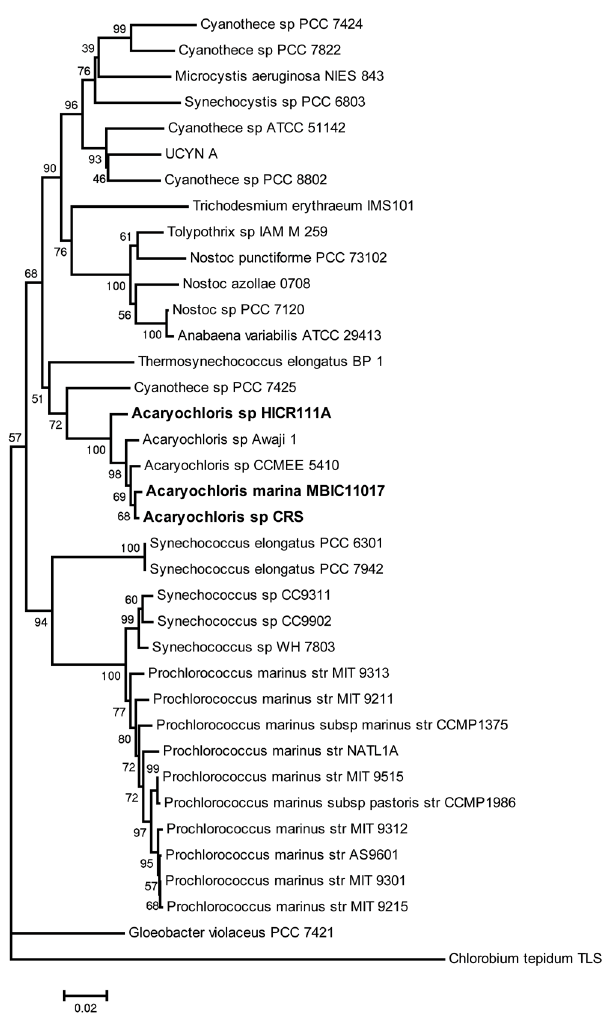
Figure 1. Phylogenetic tree indicating the position of the novel Acaryochloris strain CRS based on full-length 16S rRNA gene sequences . Sequences from other cyanobacteria (35 in total) were obtained from the SILVA database while CRS-specific sequences were obtained through PCR amplification and subsequent sequencing. Phylogeny was calculated using Neighbor-joining methods and Jukes-Cantor substitution models as implemented in MEGA5. Tree stability was assessed using bootstrapping at 10000 replications. Only bootstrap values >50% are displayed within the tree. The scale represents 0.02 substitutions per nucleotide position. The green-sulphur bacterium Chlorobium tepidum TLS was chosen as an outgroup.